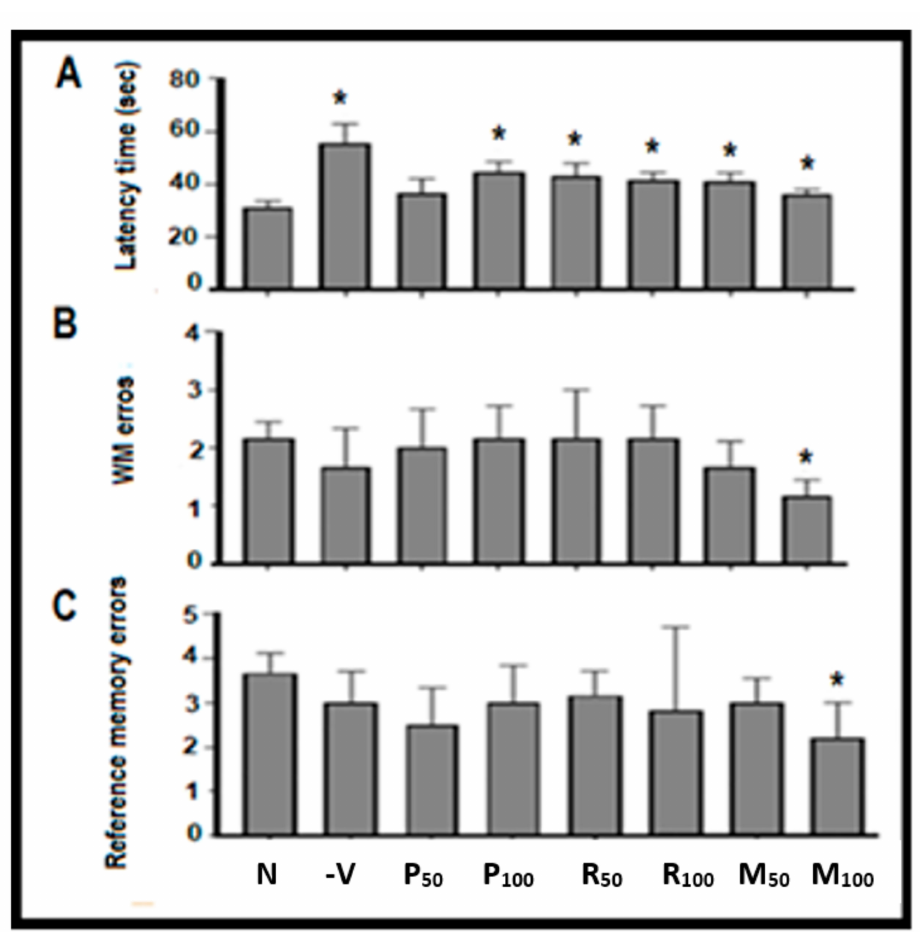
Figure 4. Behavioral analysis by radial maze test (RAM). Each rat was subjected individually to the maze and the time needed to retrieve the hidden foods was recorded. ( A ) represents the graphical blot for transition latency time (seconds) to retrieve the hidden foods in the therapeutic phase; ( B ) working memory (WM) errors; and ( C ) reference memory (RM) errors during eight visits. All were compared with the negative group. Data are presented as mean ± standard deviation (SD), n = 6 and statistical analysis by one-way ANOVA followed by Tukey’s post-hoc test. * p < 0.05. N, Normal; − V, Negative; P, peppermint oil extract; R, rosemary oil extract; PR, both peppermint oil and rosemary oil extracts in which M50 means: 25 + 25 mg of both oil extracts, while M100 means 50 + 50 mg of both